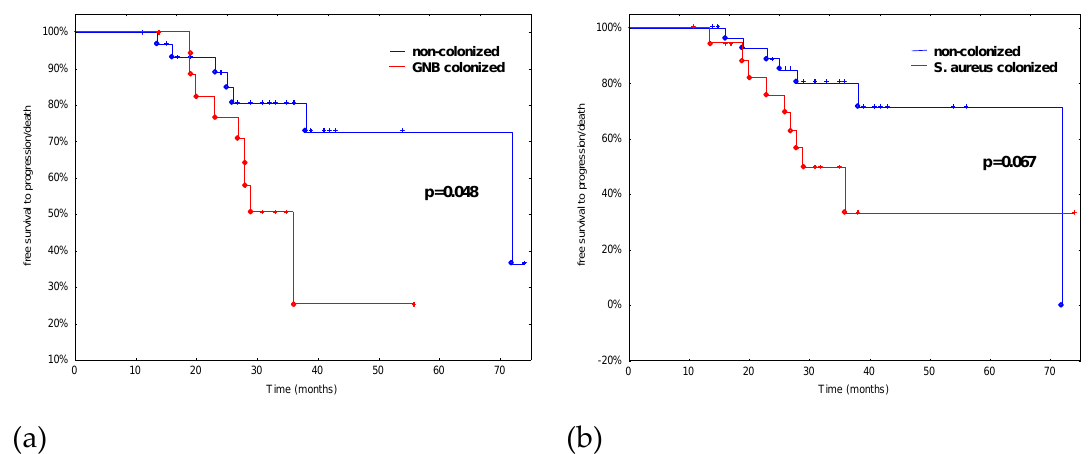
Figure 2. Effect of GNB ( a ) and S. aureus ( b ) colonization on time of free survival to disease progression/death in CLL patients.